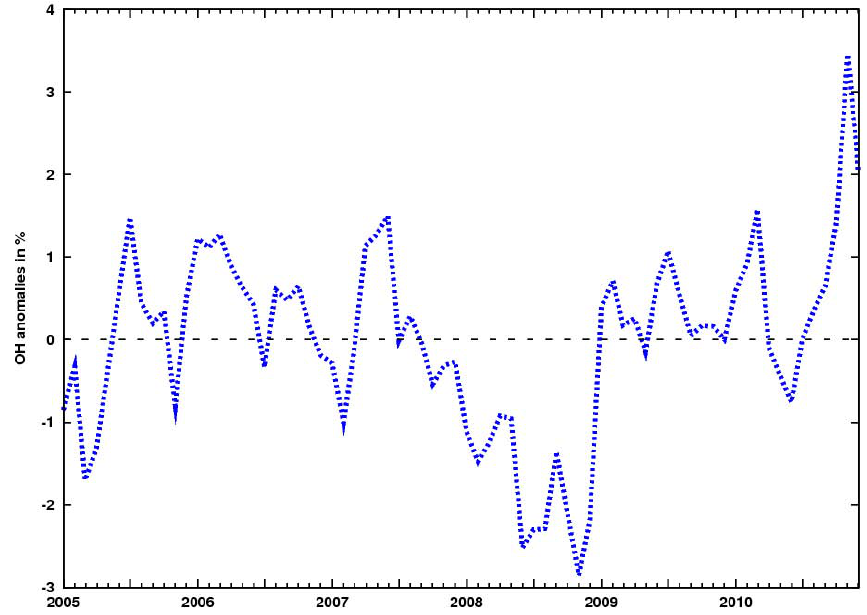
Fig. 8. Anomalies in global OH concentrations derived in our inversion from January 2005 to December 2010. Units are